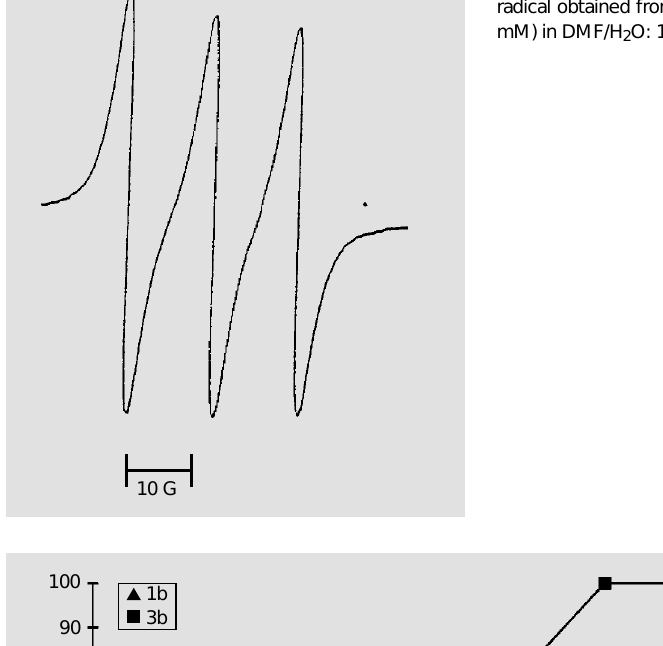
Figure 1 - ESR trapping of NO radical obtained from 1a-5a (0.1 mM) in DMF/H 2 O: 1/99.